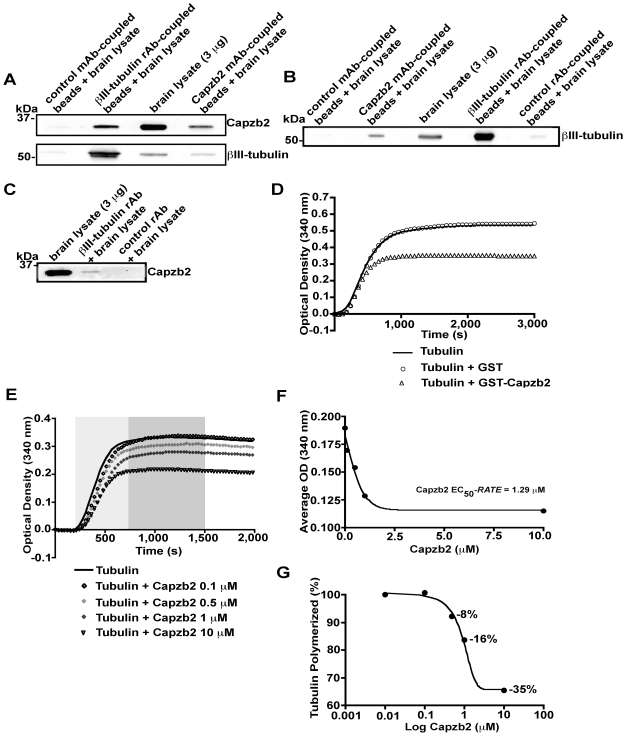
Capzb2 coimmunoprecipitates with βIII-tubulin in brain lysates and decreases tubulin polymerization in vitro.(A) In order to avoid overlap of the heavy chain signal (∼50 kDa) with the βIII-tubulin signal (∼55 kDa) in the immunoprecipitation using the Capzb2 monoclonal antibody (mAb), the antibody was coupled to the protein G/A beads through cross-linking. βIII-tubulin and Capzb2 signals were each detected following immunoprecipitation from brain lysate with both βIII-tubulin rabbit antibody (rAb)-coupled beads and Capzb2 mAb-coupled beads. The expected molecular weight of Capzb2 (28–32 kDa) and βIII-tubulin (∼55 kDa) is confirmed in brain lysate (3 µg). (B) Similarly, βIII-tubulin signal was detected specifically both in immunoprecipitations with Capzb2 mAb-coupled beads and with βIII-tubulin rAb-coupled beads, as confirmed in the brain lysate lane. (C) Capzb2 was also specifically precipitated also by βIII-tubulin rAb that was not cross-linked to the protein G/A beads; the expected molecular weight of Capzb2 was detected in the brain lysate lane. (D) Tubulin monomers were incubated in the presence of 0.05 mg/ml tau only or together with 10 µM of GST-Capzb2 or 10 µM of GST-tag. GST-tag alone did not alter tubulin polymerization. GST-Capzb2 decreased the maximal level of microtubule assembly by approximately 40%. Curves represent mean change in optical density (OD) at 30-s intervals. (E) Capzb2 decreases the rate and the extent of tubulin polymerization in a concentration-dependent manner. The lightly shaded region indicates the exponential phase of tubulin polymerization. The darkly shaded region indicates the interval in which the final extent of tubulin polymerization is achieved. (F) To determine the concentration of Capzb2 required for 50% reduction in the rate of tubulin polymerization (Capzb2 EC50-RATE), a nonlinear sigmoidal curve was fitted to the average OD during the exponential phase of tubulin polymerization (interval 180–750 s; lightly shaded in [E]) versus Capzb2 concentration. Each point depicted represents the average of 20 OD readings obtained for each Capzb2 concentration examined (0, 0.1, 0.5, 1, and 10 µM) during the interval 180–750 s; R
2 (correlation coefficient) = 0.99. (G) In the presence of increasing of Capzb2 concentrations of 0.5, 1, and 10 µM, the extent of tubulin polymerization is reduced by 8%, 16%, and 35%, respectively. The average of 25 OD readings obtained for each of the Capzb2 concentrations examined was normalized against the average OD reading in the absence of Capzb2 during 750–1,500-s interval (darkly shaded in [E]) in which the final extent of tubulin polymerization is achieved for a given reaction. Capzb2 concentration is displayed on a log of 10 scale, so the first depicted point (tubulin polymerization in the absence of Capzb2; OD value = 100%) on the obtained nonlinear sigmoidal curve (R
2 = 0.99) corresponds to 0.01 on the Log Capzb2 (µM). The concentration of 0.1 µM Capzb2 (the second depicted point on the curve) does not reduce the extent of tubulin polymerization although it does affect the rate (as seen in [F]).